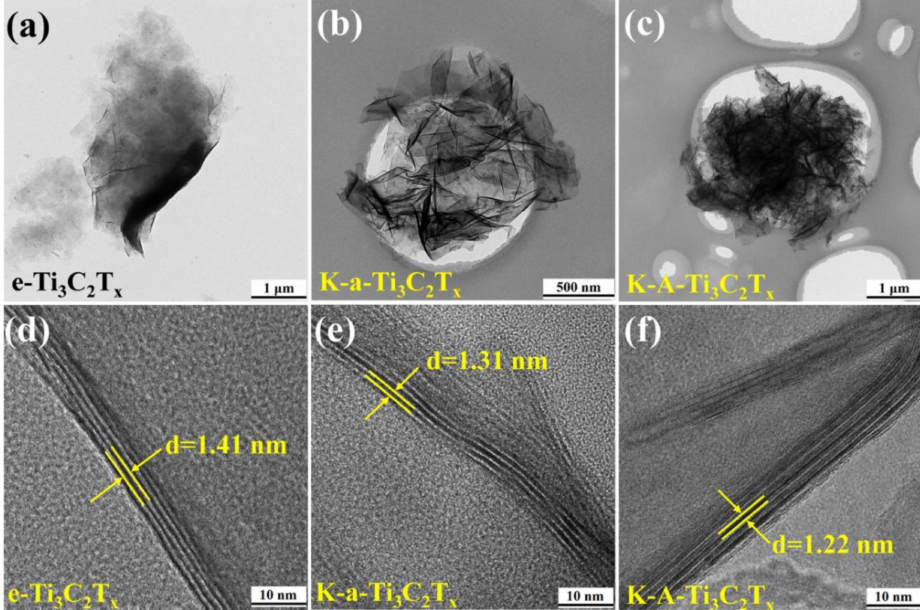
Figure 6. TEM images of: ( a ) e-Ti 3 C 2 T x , ( b ) K-a-Ti 3 C 2 T x , ( c ) K-A-Ti 3 C 2 T x and HRTEM images of: